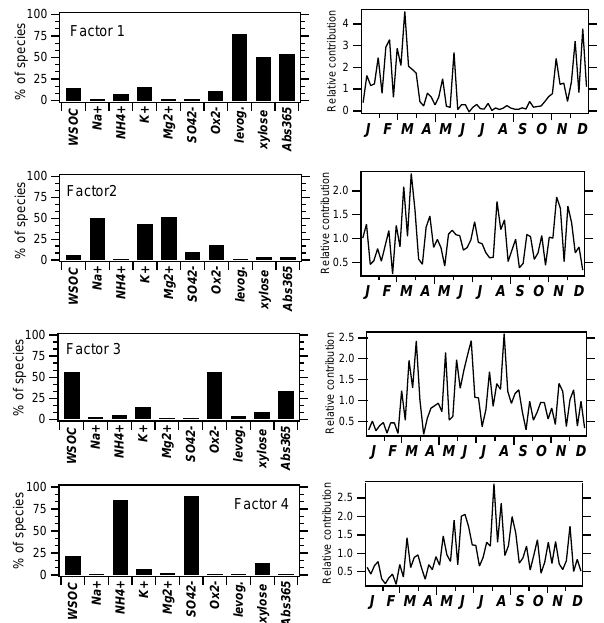
Fig. 9. Composition profiles (% of total of each species) for the four factors resolved by PMF based on data from the whole year (2007) at all sites (left panel), and the time series of relative contribution of each factor (right